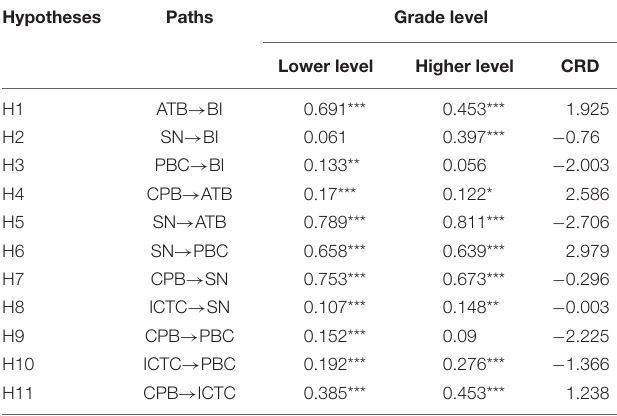
TABLE 4 | Standardized path coefficients in SEM or grade